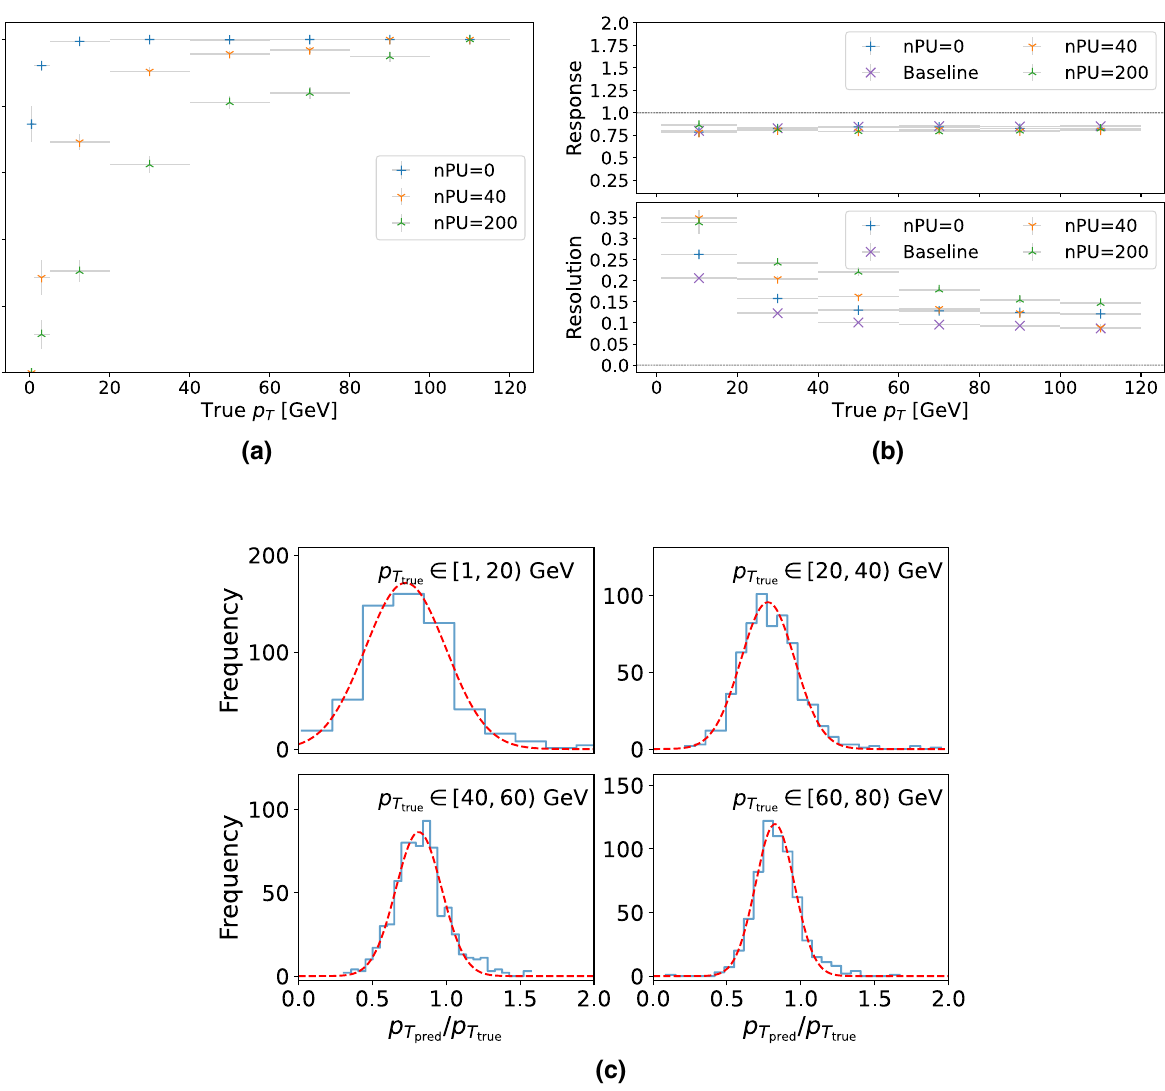
Fig. 11 Reconstruction performance of hadrons ( π + ) in different pileup environments. a Efficiency as a function of the true p T . b Mean response (top) and resolution (bottom) as functions of the true p T . The response and resolution are computed as the mean and mean-corrected